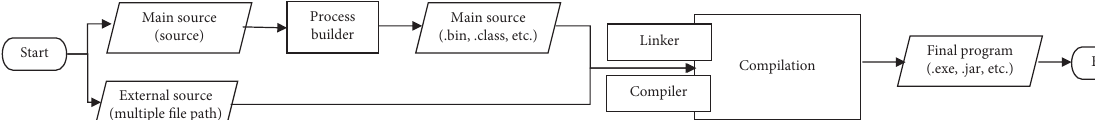
Figure 2: Complex multifile program linker in dynamic grading.